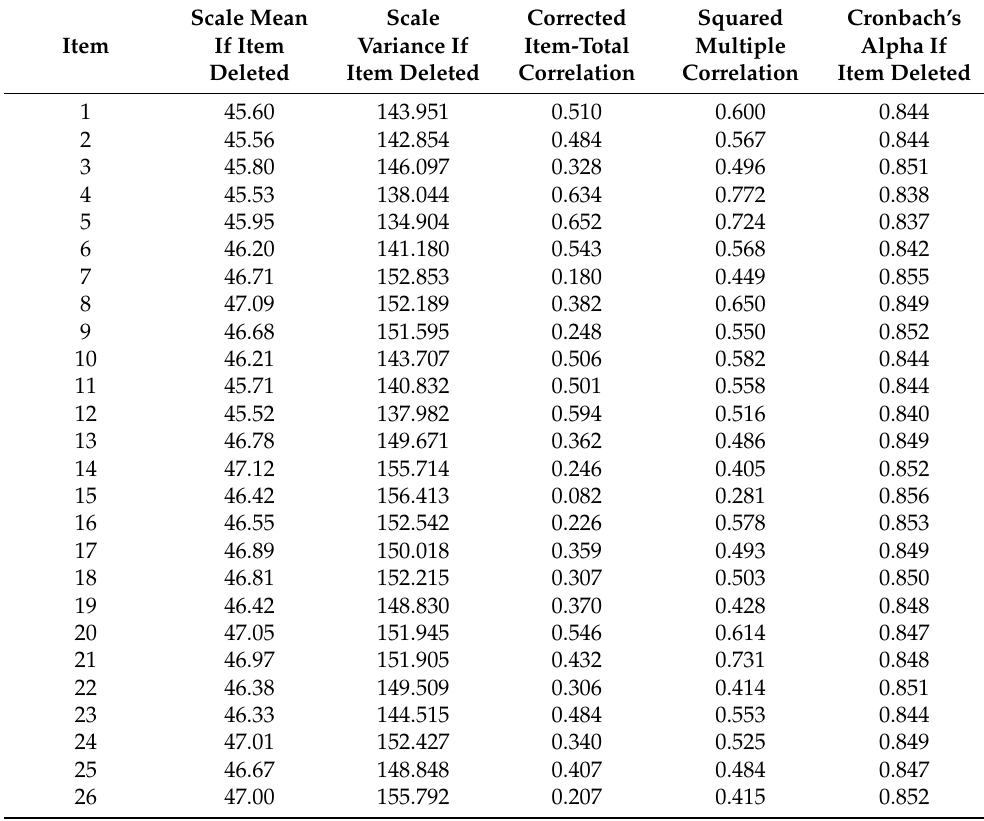
Table 2. Item–total correlation of the